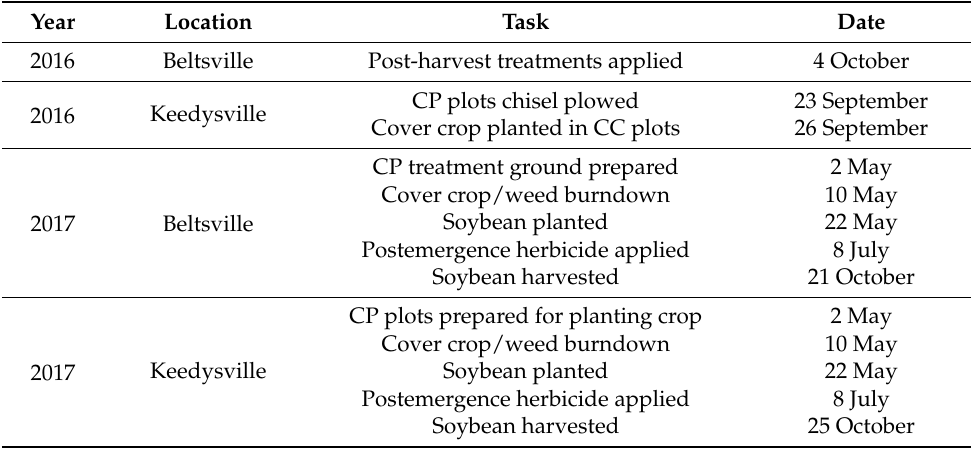
Table 1. Timing of field operations for the 2017 and 2018 field